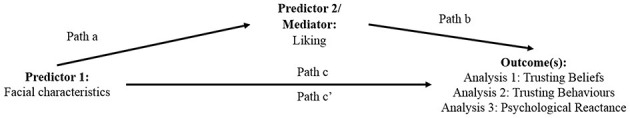
Liking rate fully mediates the relationship between facial characteristics and both trusting beliefs (in analysis 1) and psychological reactance (in analysis 3). However, liking rate did not mediate the relationship between facial characteristics and trusting behaviors (in analysis 2).